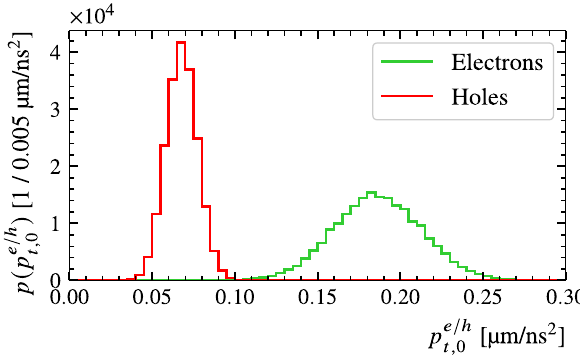
/ h ) , of the two t , 0